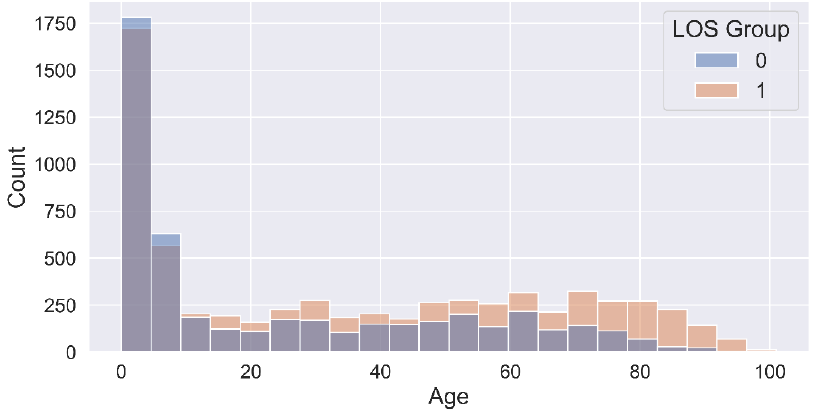
Figure 4. Age distribution among the LOS groups.